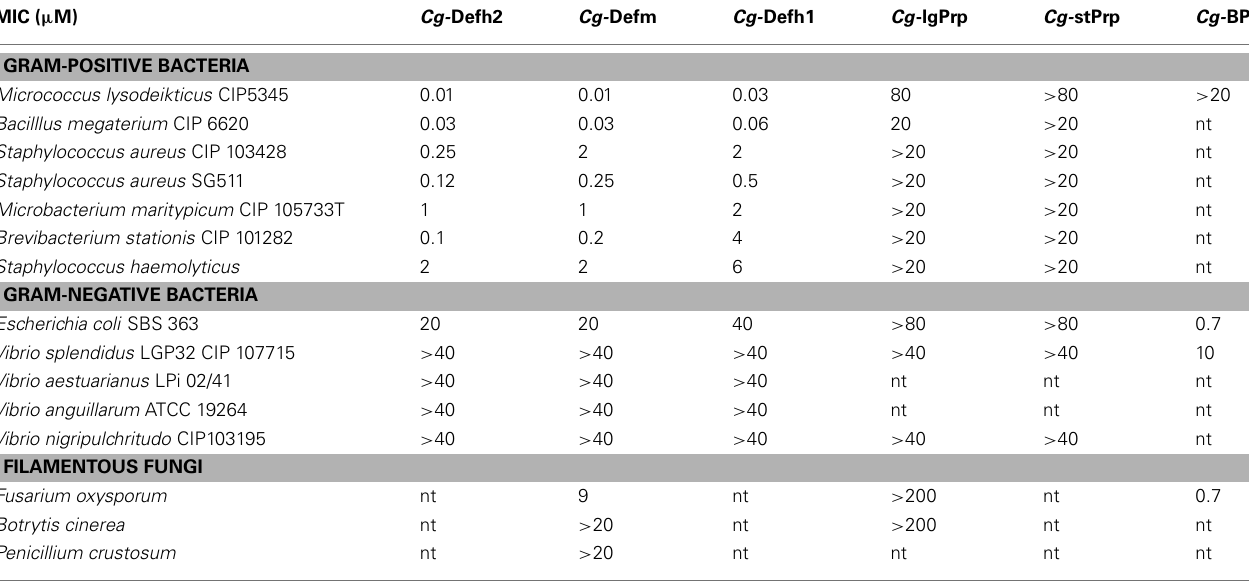
Table 2 |Antimicrobial activities of Cg -Defs, Cg -Prps, and Cg -BPI against selected microorganisms. MIC ( μ